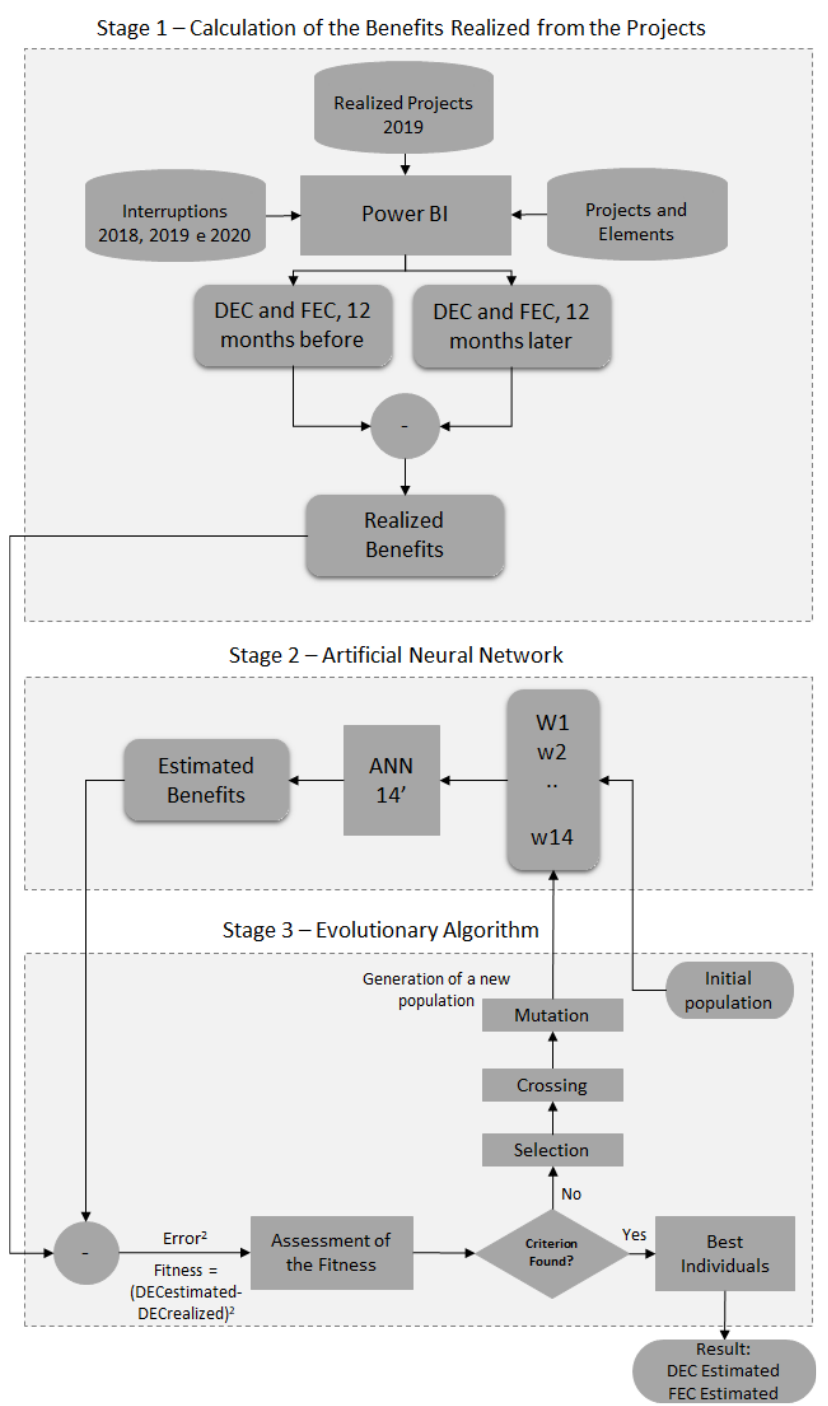
Figure 1. Proposed methodology for evaluating the quality of service projects.